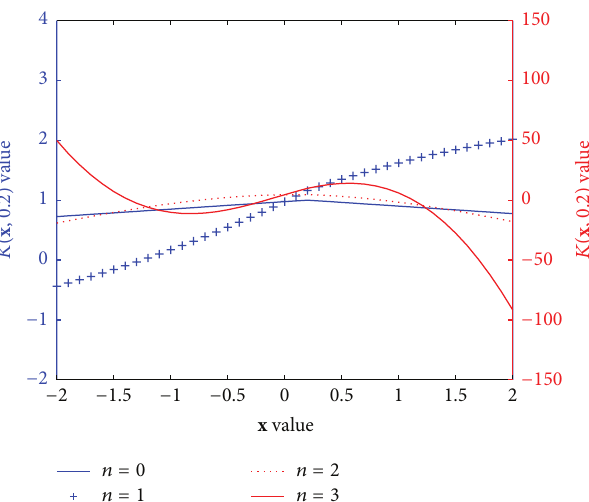
Figure 4: The Triangular Hermite kernel output 𝐾 Tri the 3rd order: 𝑥 ∈ [−0.5, 0.5] and 𝑧 = 0.2.